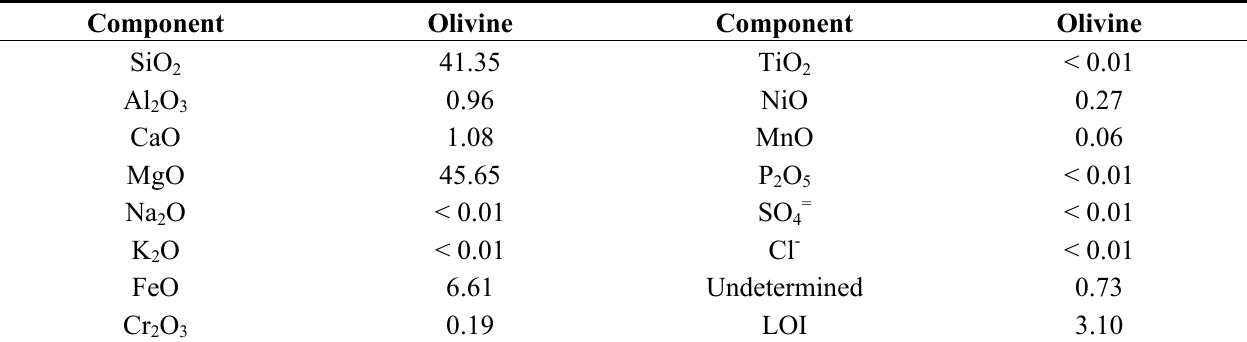
Table 2. Composition (wt%) and lost on ignition (LOI) (%) of Olivine (O) used as starting material in the present